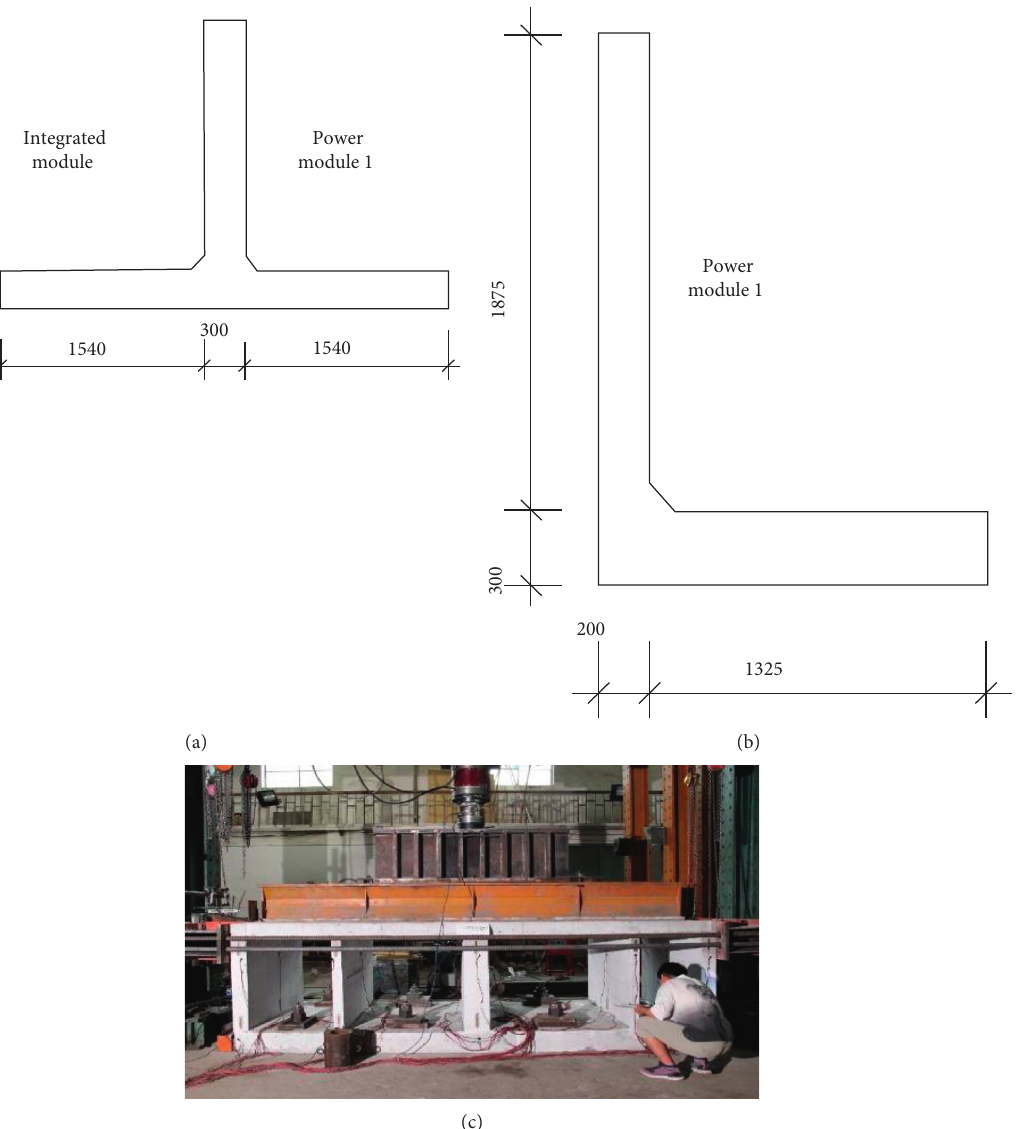
Figure 2: Joint specimen size and integral photo: (a) middle joint specimen; (b) side joint specimen; (c) overall specimen (unit: mm).